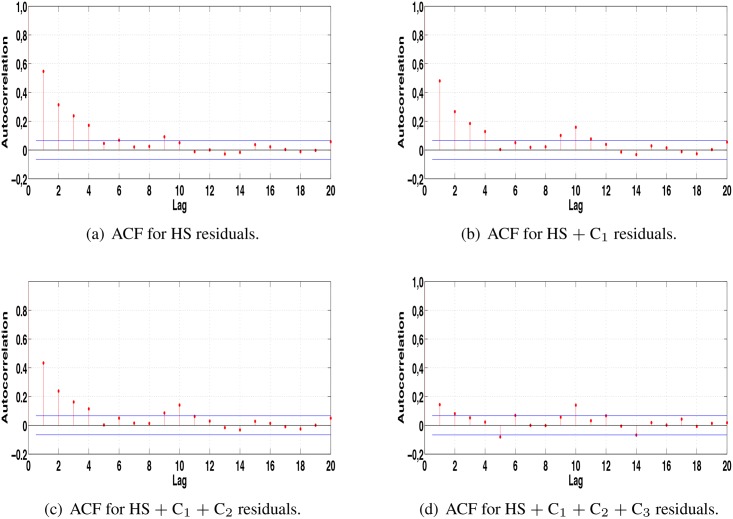
Autocorrelation (ACF) for PM10 concentration series for Kallio station.